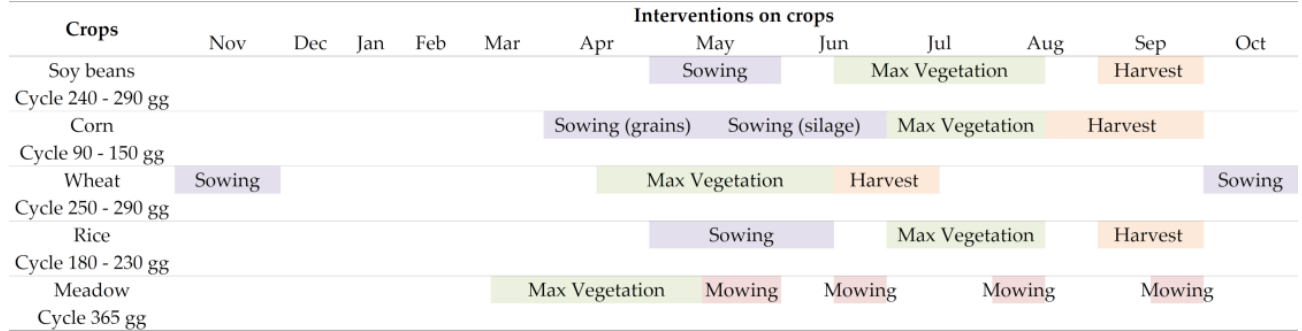
Figure 1. Study area (yellow) is located within the province of Vercelli in the Piemonte Region, NW Italy. (Reference system is WGS 84/UTM zone 32N, EPSG: 32632).